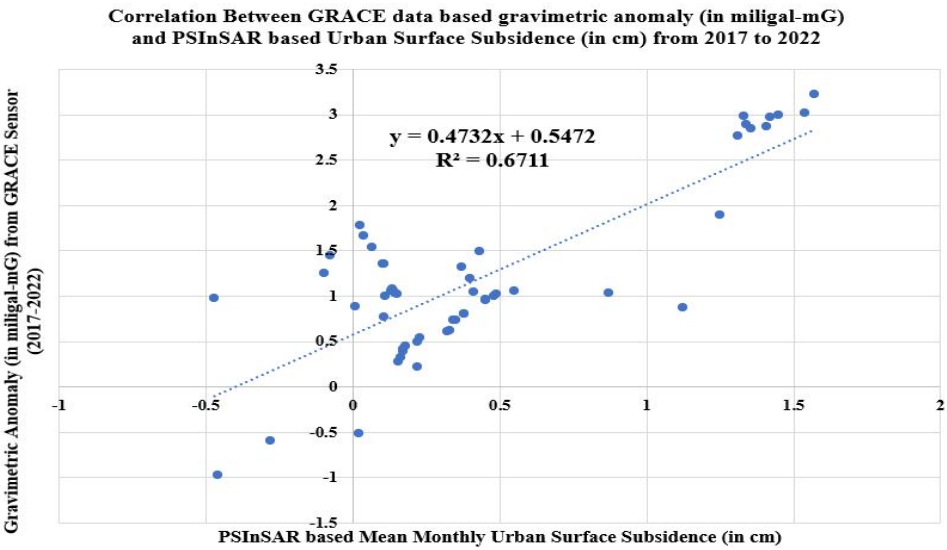
Figure 10. Correlation between average GRACE data and average PSInSAR findings from Sentinel-1 SAR data month-wise from 2017 to 2022.